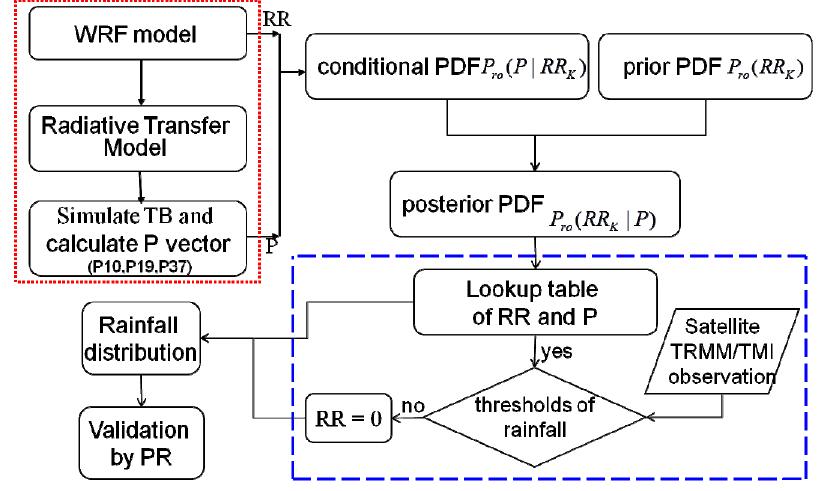
Figure 3. Flowchart for precipitation estimation proposed in this study.